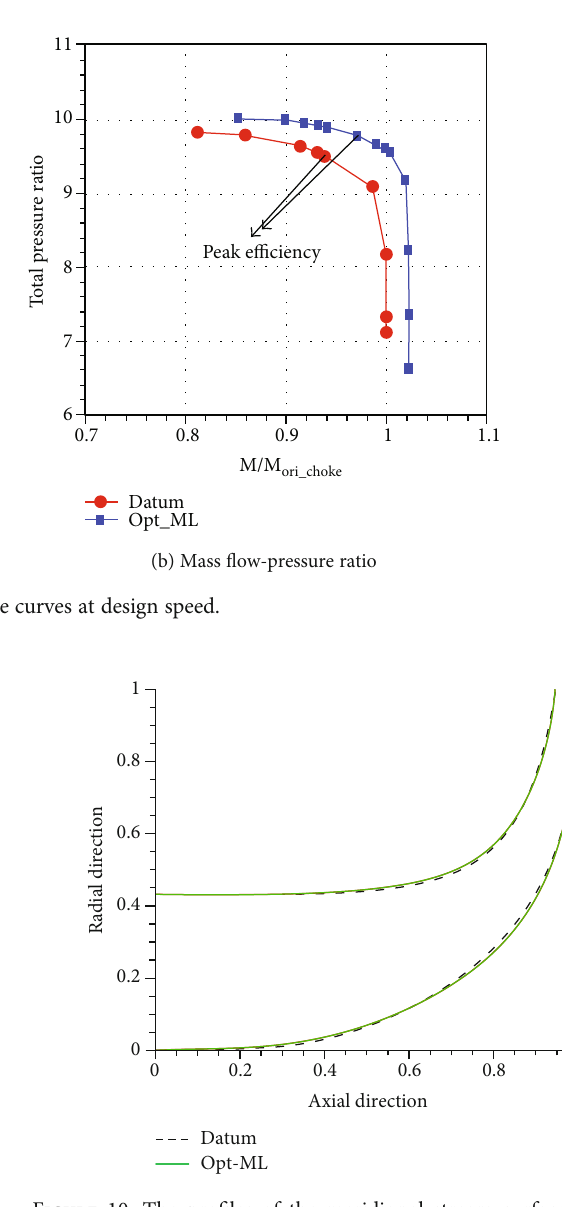
Figure 10: The pro fi les of the meridional stream surface of two optimal blades and